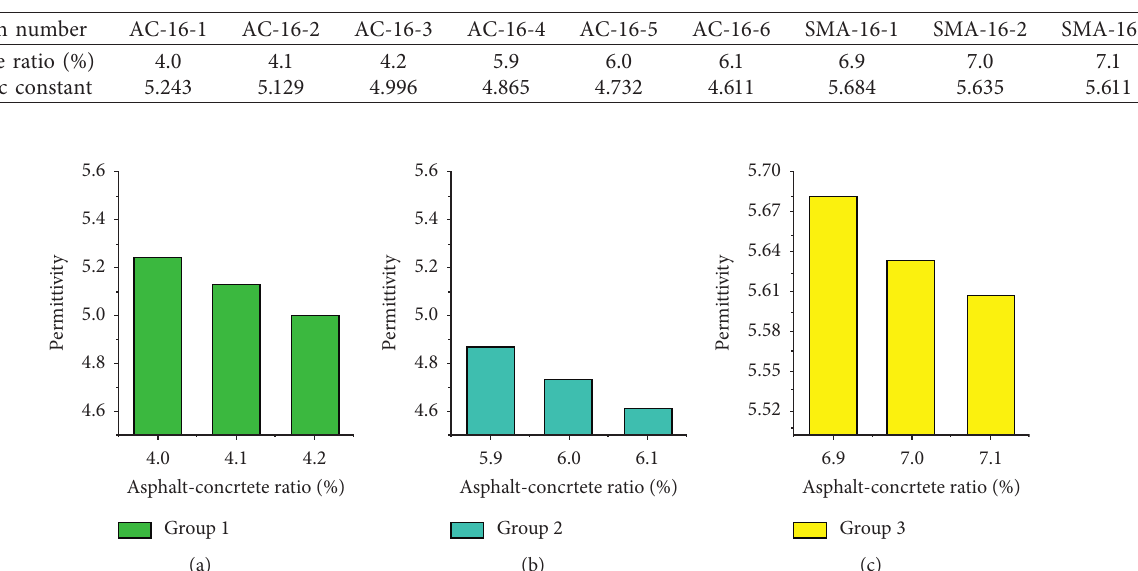
Figure 3: Permittivity of asphalt and limestone. Table 2: Dielectric constant of asphalt mixture specimens.